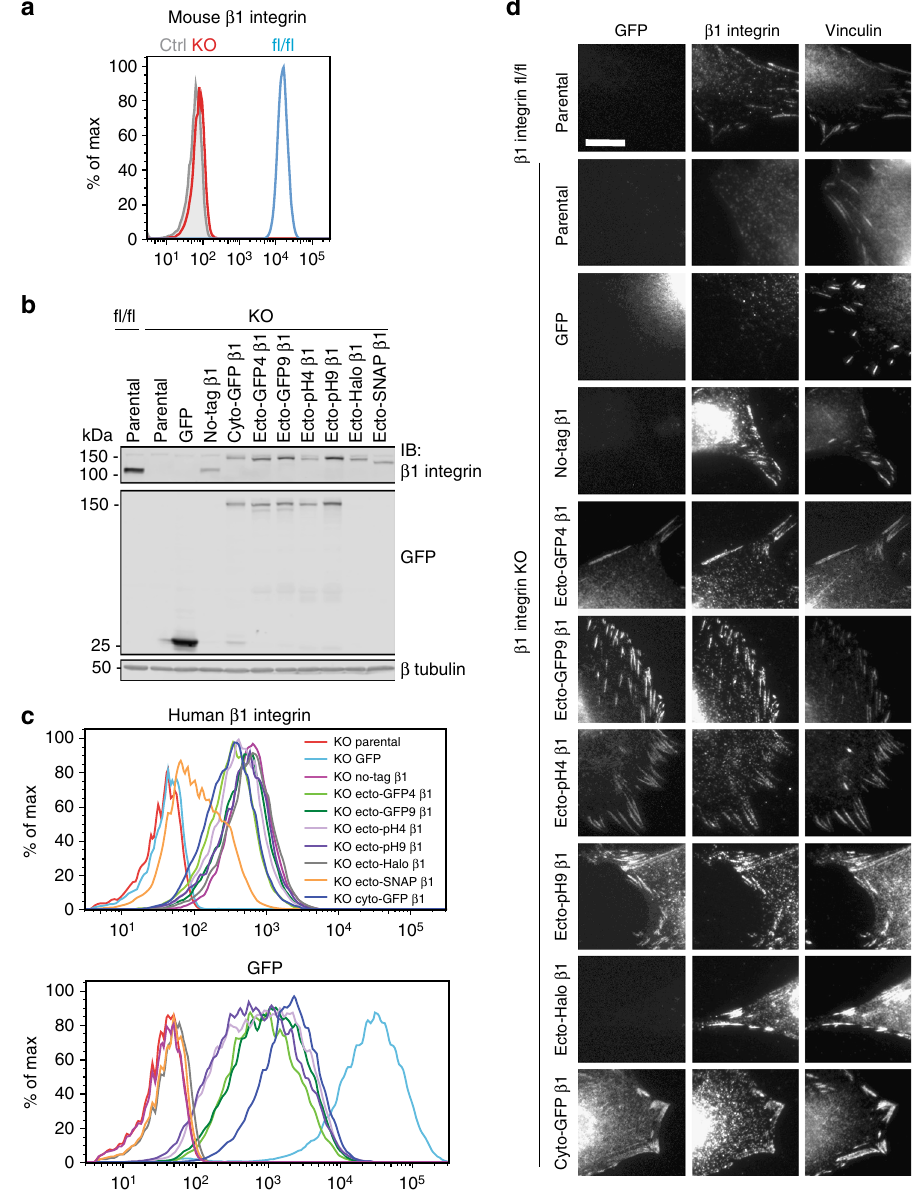
Fig. 2 Ecto-tagged β 1 integrins translocate to the cell surface and target to FAs. a Flow cytometric analysis of cell surface levels of mouse β 1 integrin in β 1 integrin fl / fl ( blue peak ) and KO fi broblasts ( red peak ), and control unstained KO fi broblasts ( gray peak ). b Immunoblot detection of endogenous and ectopic β 1 integrins in lysates of 100,000 fl / fl and KO fi broblasts using a pan- β 1 integrin antibody ( top panel ) and an anti-GFP antibody ( middle panel ). Tubulin was used as a loading control ( bottom panel ). Uncropped blots are available in Supplementary Fig. 10. c Flow cytometric analysis of cell surface levels of human β 1 integrins ( top panel ) and GFP fl uorescence ( bottom panel ) in parental and reconstituted β 1 integrin KO fi broblasts. d Microscopy images of parental and reconstituted fl / fl and KO fi broblasts showing GFP epi fl uorescence ( left column ), β 1 integrin immuno fl uorescence with 9EG7 antibody ( center column ), and vinculin immuno fl uorescence ( right column ). Scale bar , 10 μ m antibodies have allowed measurement of integrin internalization and recycling rates, fully understanding how integrin traf fi cking is orchestrated and its role in cell physiology and pathology requires sophisticated microscopy tools designed to follow speci fi c pools of integrins in live cells. To date, direct visualization of integrin exocytosis has not been possible but integrin endocytosis has been imaged using either integrin subunits fused to a cytoplasmic fl uorescent protein (cyto-tagged), or indirect integrin labeling with – 17 . Together with FRAP and pho- speci fi c ligands or antibodies 15 toconversion techniques, cyto-tagged integrins have been powerful tools to visualize integrin internalization and turnover 18, 19 . NATURE COMMUNICATIONS | 8: 570 | DOI: 10.1038/s41467-017-00646-w |